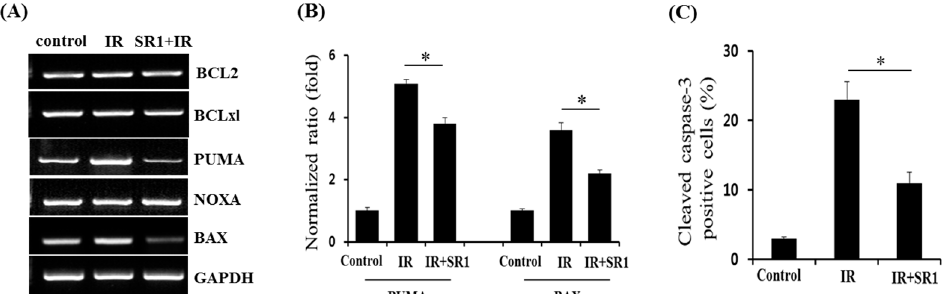
Figure 5. SR1-mediated reduction in the expression of pro-apoptotic BCL-2 family proteins and caspase-3 activity in irradiated HSPCs. ( A ) RT-PCR analysis of the expression of anti-apoptotic BCL-2 family (BCL-2 and BCL-XL) and pro-apoptotic BCL-2 family (PUMA, NOXA, and BAX) members in HSPCs with or without SR1 on day 3 after irradiation. GAPDH was used as an internal control. ( B ) Quantification of PUMA and BAX (pro-apoptotic BCL-2 family) expression. Protein quantification was performed using densitometry. ( C ) Caspase-3 activity assay in HSPCs with or without SR1 on day 3 after irradiation using a cleaved caspase-3 ELISA kit. The data are shown as means ± SDs of triplicate experiments (* p < 0.05, two-tailed Student’s t -test).